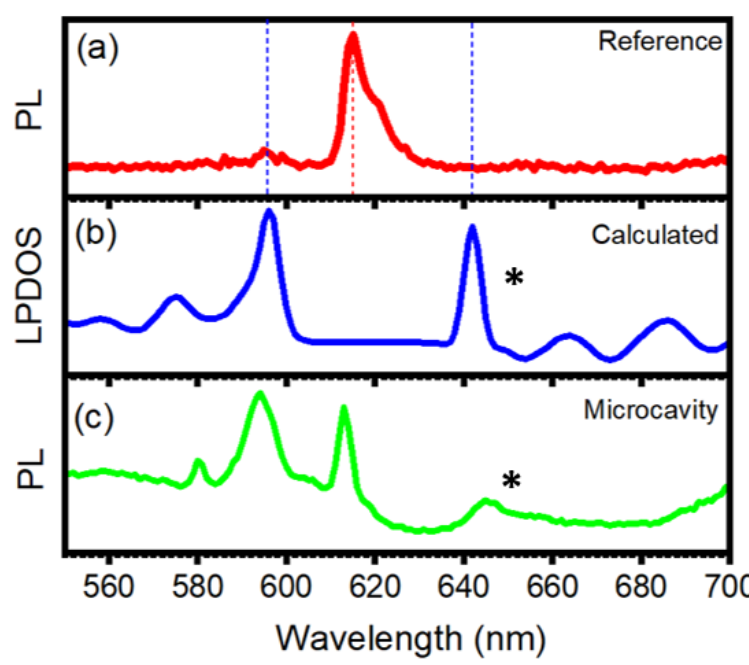
Figure 3. ( a ) EuD 4 TEA:PS reference emission spectrum, ( b ) calculated local density of photonic states (LPDOS) for the microcavity and ( c ) emission spectrum of the microcavity, the microcavity spectral position is marked with (*).